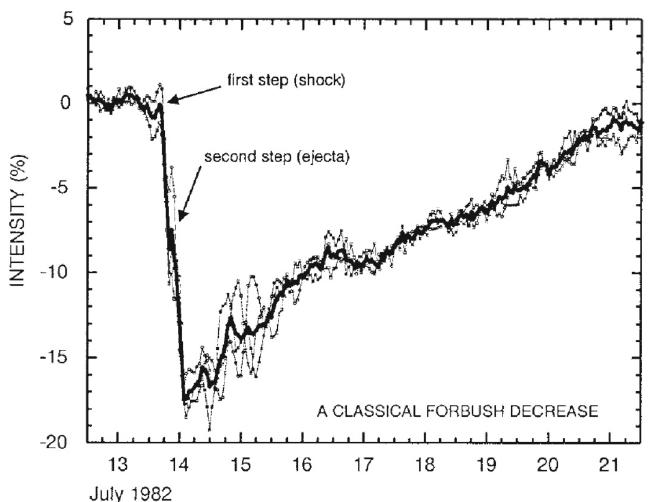
Fig. 3 Forbush decrease associated with a shock-driving ICME. Image reproduced by permission from Cane (2000), copyright by